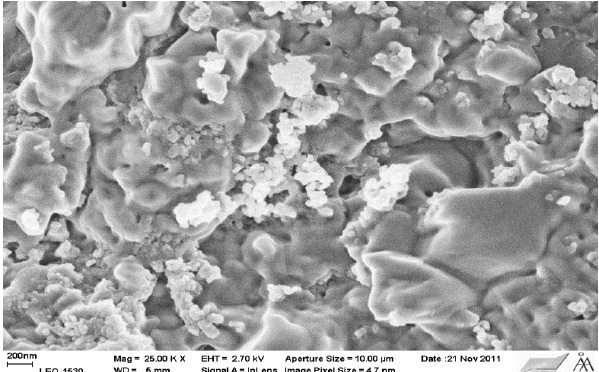
Figure 3. SEM of 20 wt %